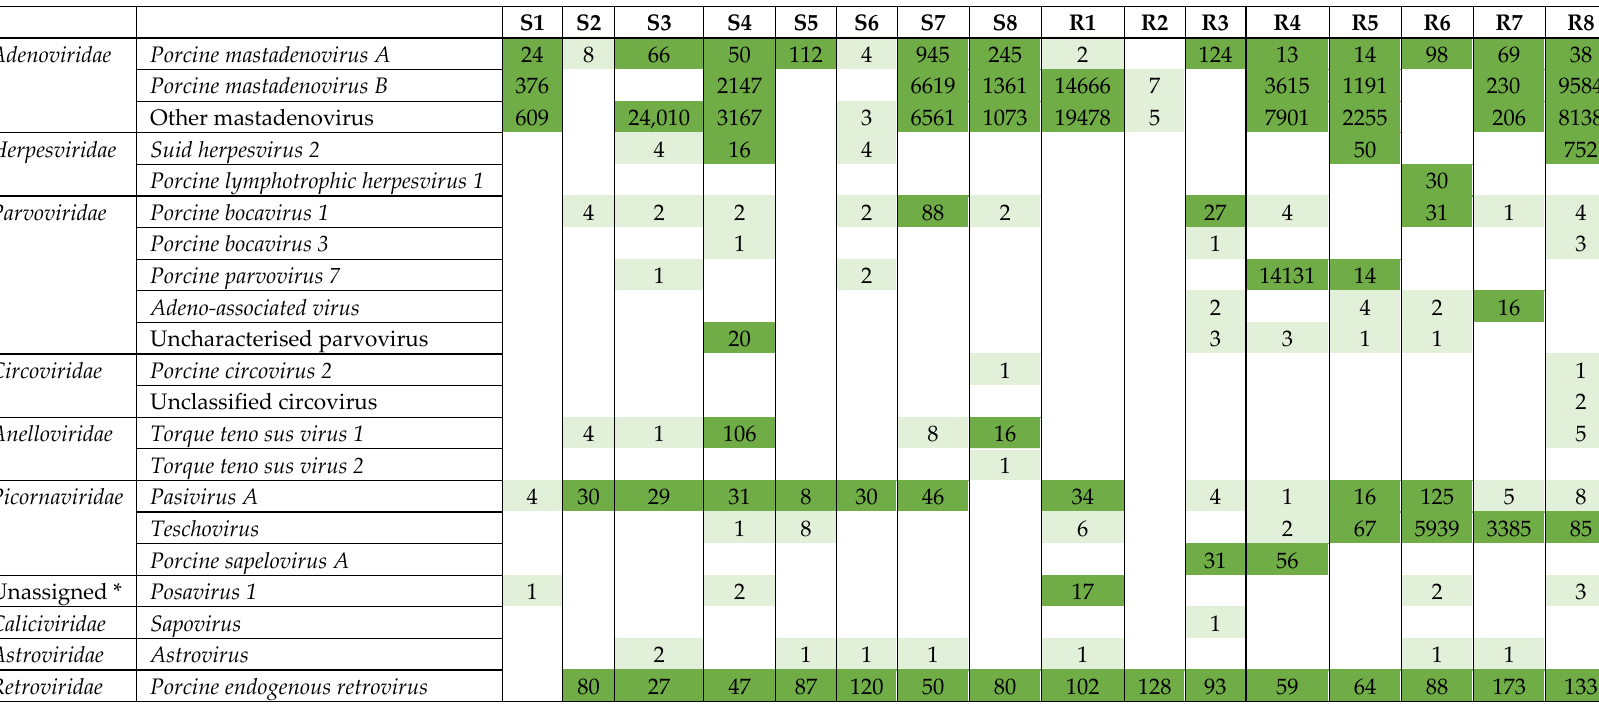
Table 1. Viruses identified in the viral metagenomic analysis. The table displays the viruses identified in each of the 16 pigs—eight specific pathogen-free pigs (S1 to S8) and eight conventionally reared pigs from a herd with respiratory problems (R1 to R8). Green means that the pig was positive for the specific virus, and the number indicates how many individual reads mapped to each virus; the viruses with less than 10 reads per sample are marked with a lighter green. * Posavirus 1 has not been assigned to a viral family but is placed within the Picornavirales order.